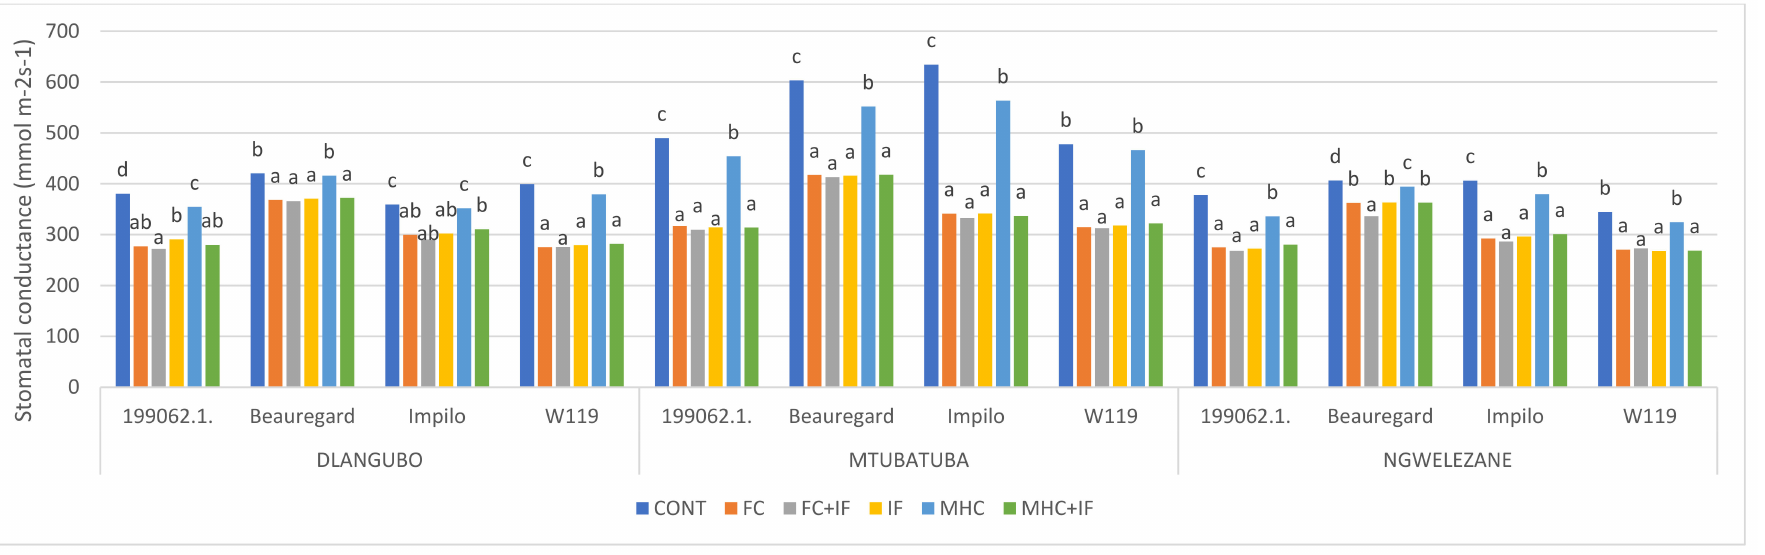
Figure 6. Leaf stomatal conductance of orange-fleshed sweet potato grown at Dlangubo, Mtubatuba, and Ngwelezane. Each bar represents the average of data collected in season one and season two of 2021. ANOVA was performed across treatments. Means of replications were separated at LSD 0.05 . Post hoc was done using a Tukey test. The means of the treatments for each cultivar in a site with different letters were significantly different ( p < 0.05, n =